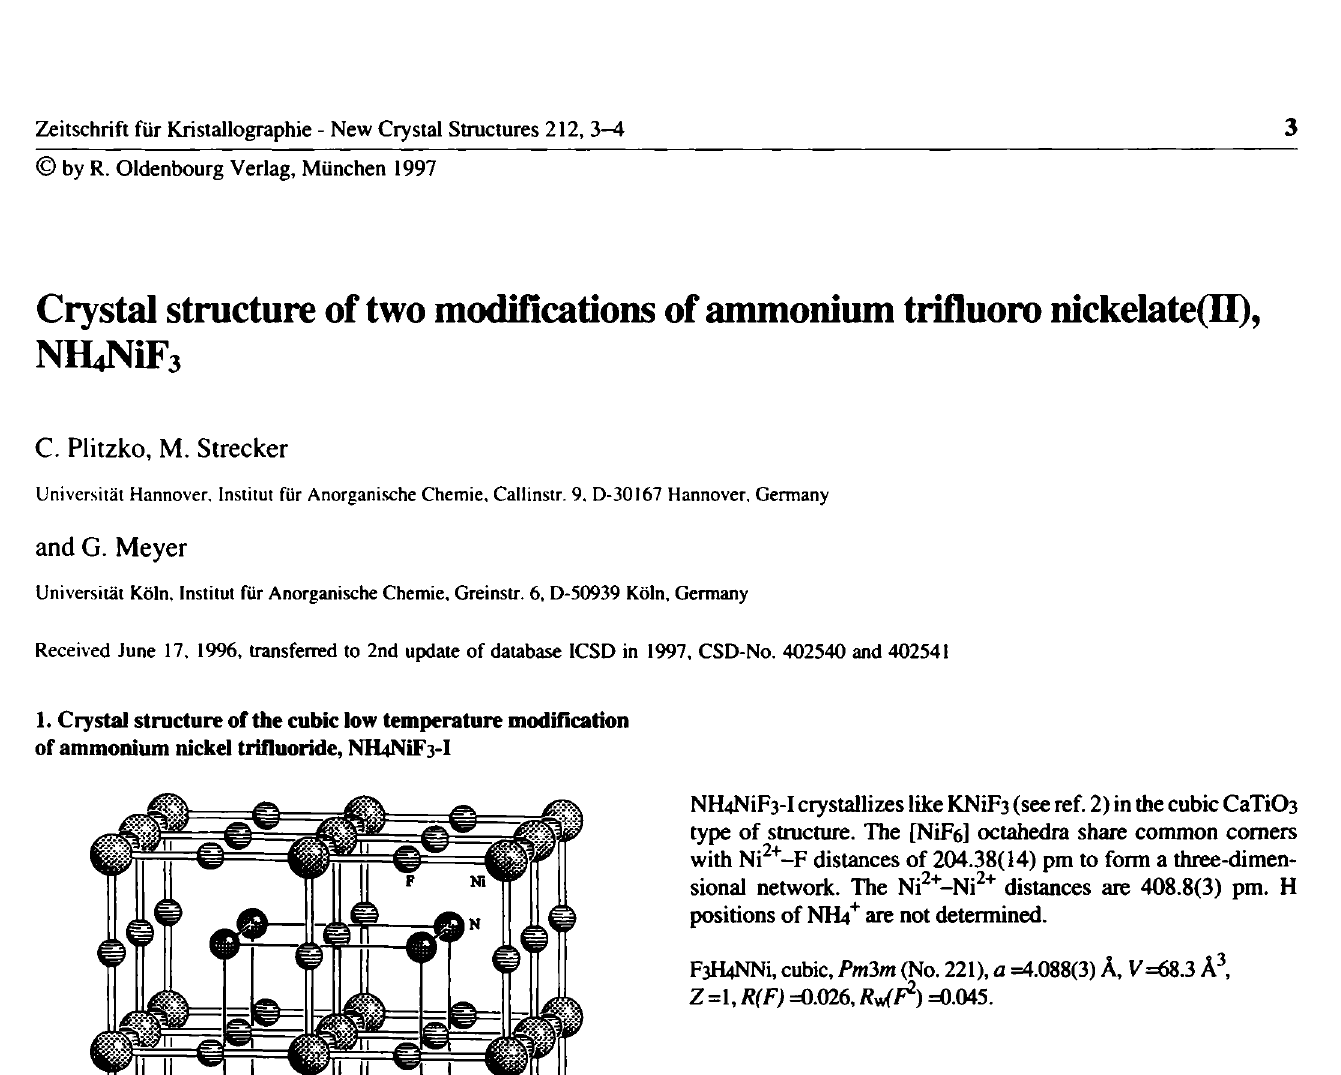
Table 1. Parameters used for the X-ray data collection